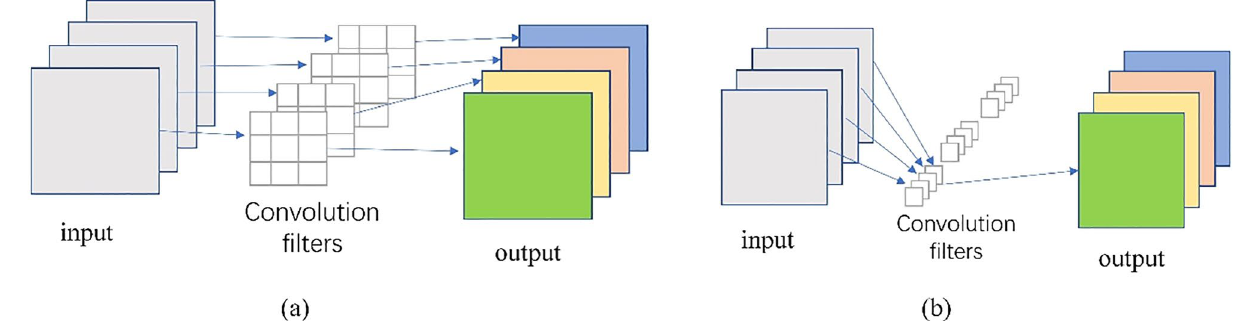
Figure 2. The depth-wise separable convolution consists of two parts: ( a ) depth-wise convolution. ( b ) 1 × 1